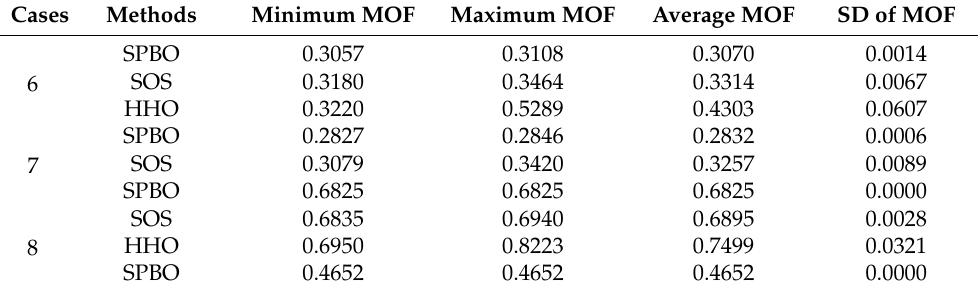
Table 18. Statistical performance of different methods for 118-bus system.